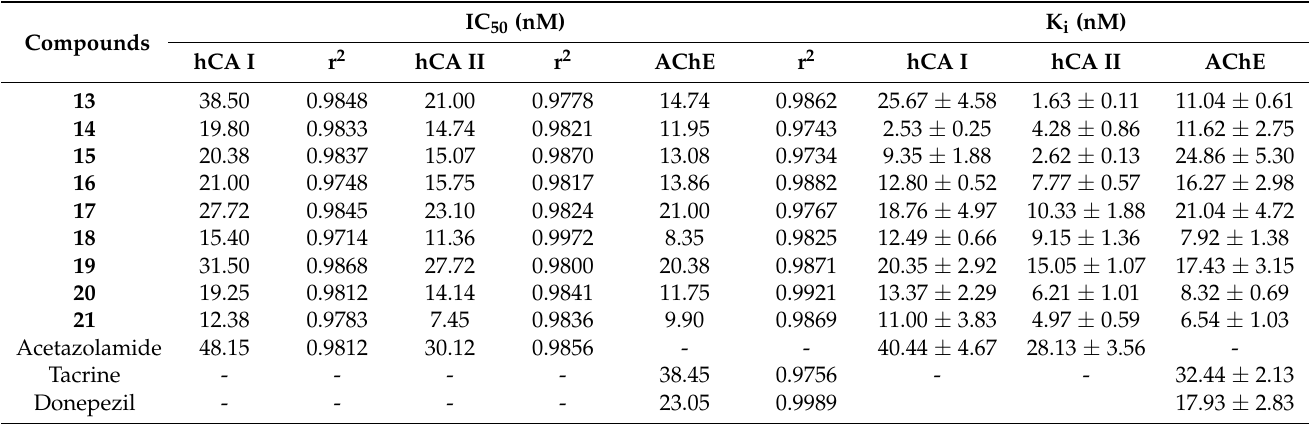
Table 1. Inhibition parameters of the novel synthesized bromophenols ( 13 – 21 ) against AChE, hCA I, and hCA II